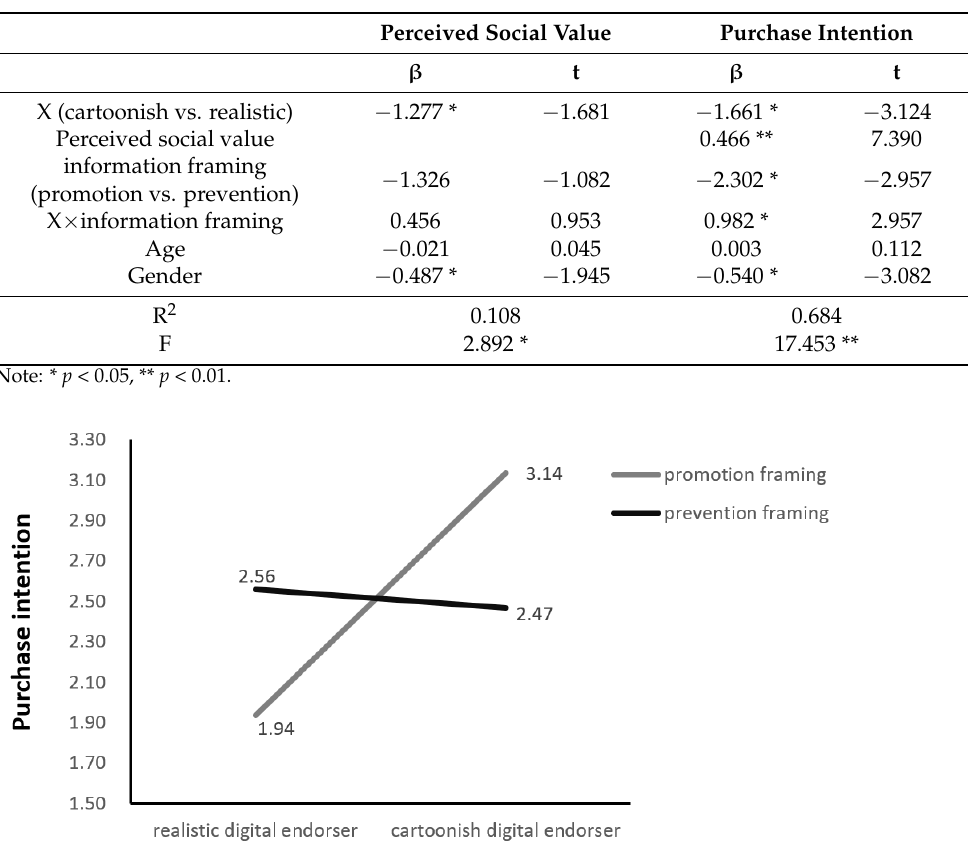
Table 2. Results of moderated mediation analysis.